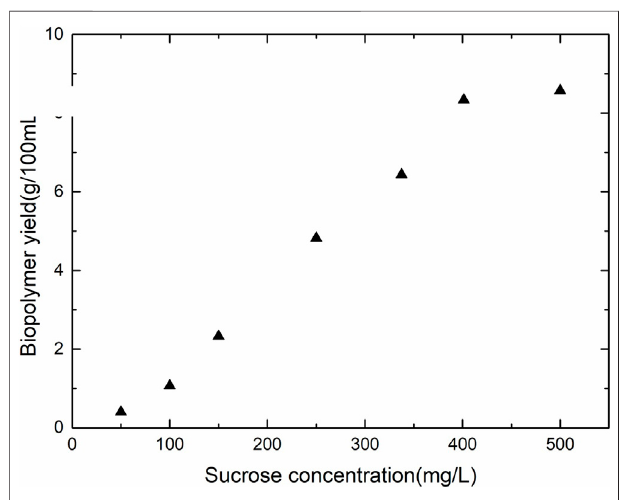
FIGURE 4 | Biopolymer yield with varying sucrose